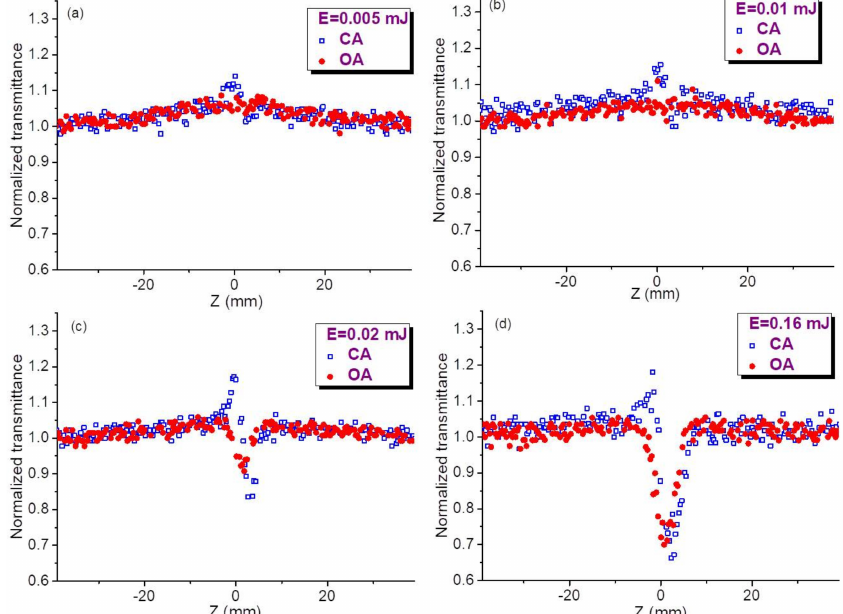
Figure 2. Open-aperture (OA, red filled circles) and closed-aperture (CA, blue empty squares) z-scans of InP@ZnS CQDs ( C = 2 × 10 − 6 M) measured at different energies of 532 nm pulses. ( a ) 0.005 mJ,